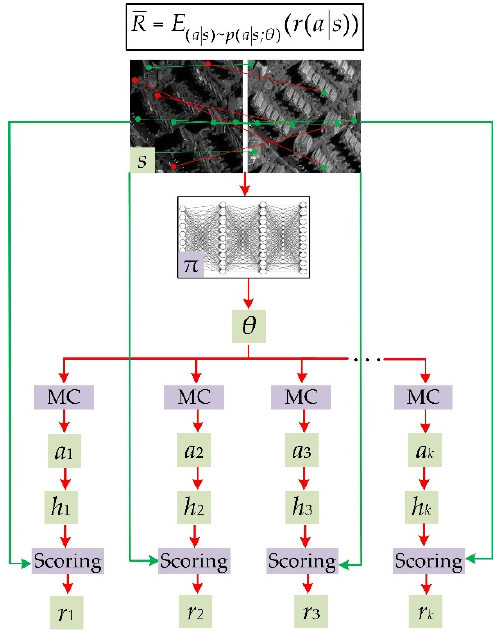
Figure 2. Schematic plot of learning to remove mismatches via DRL. The objective function (Equa- tion (5)) is shown in the box at the top.